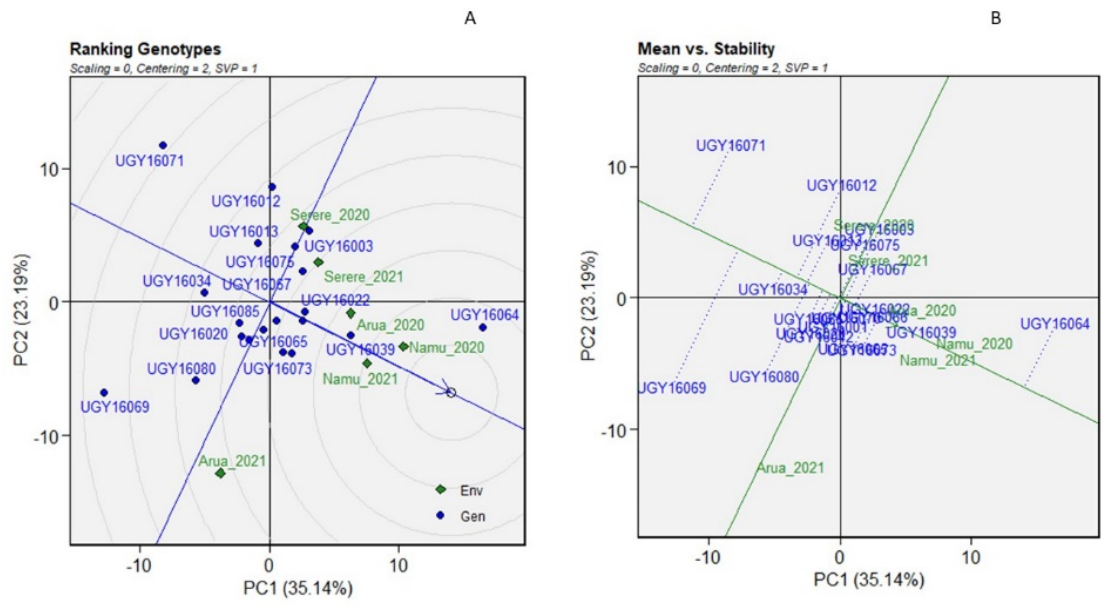
Figure 8. GGE ranking biplots showing ( A ) the mean performance and ( B ) stability for dry matter content of 20 yam genotypes evaluated in six environments.